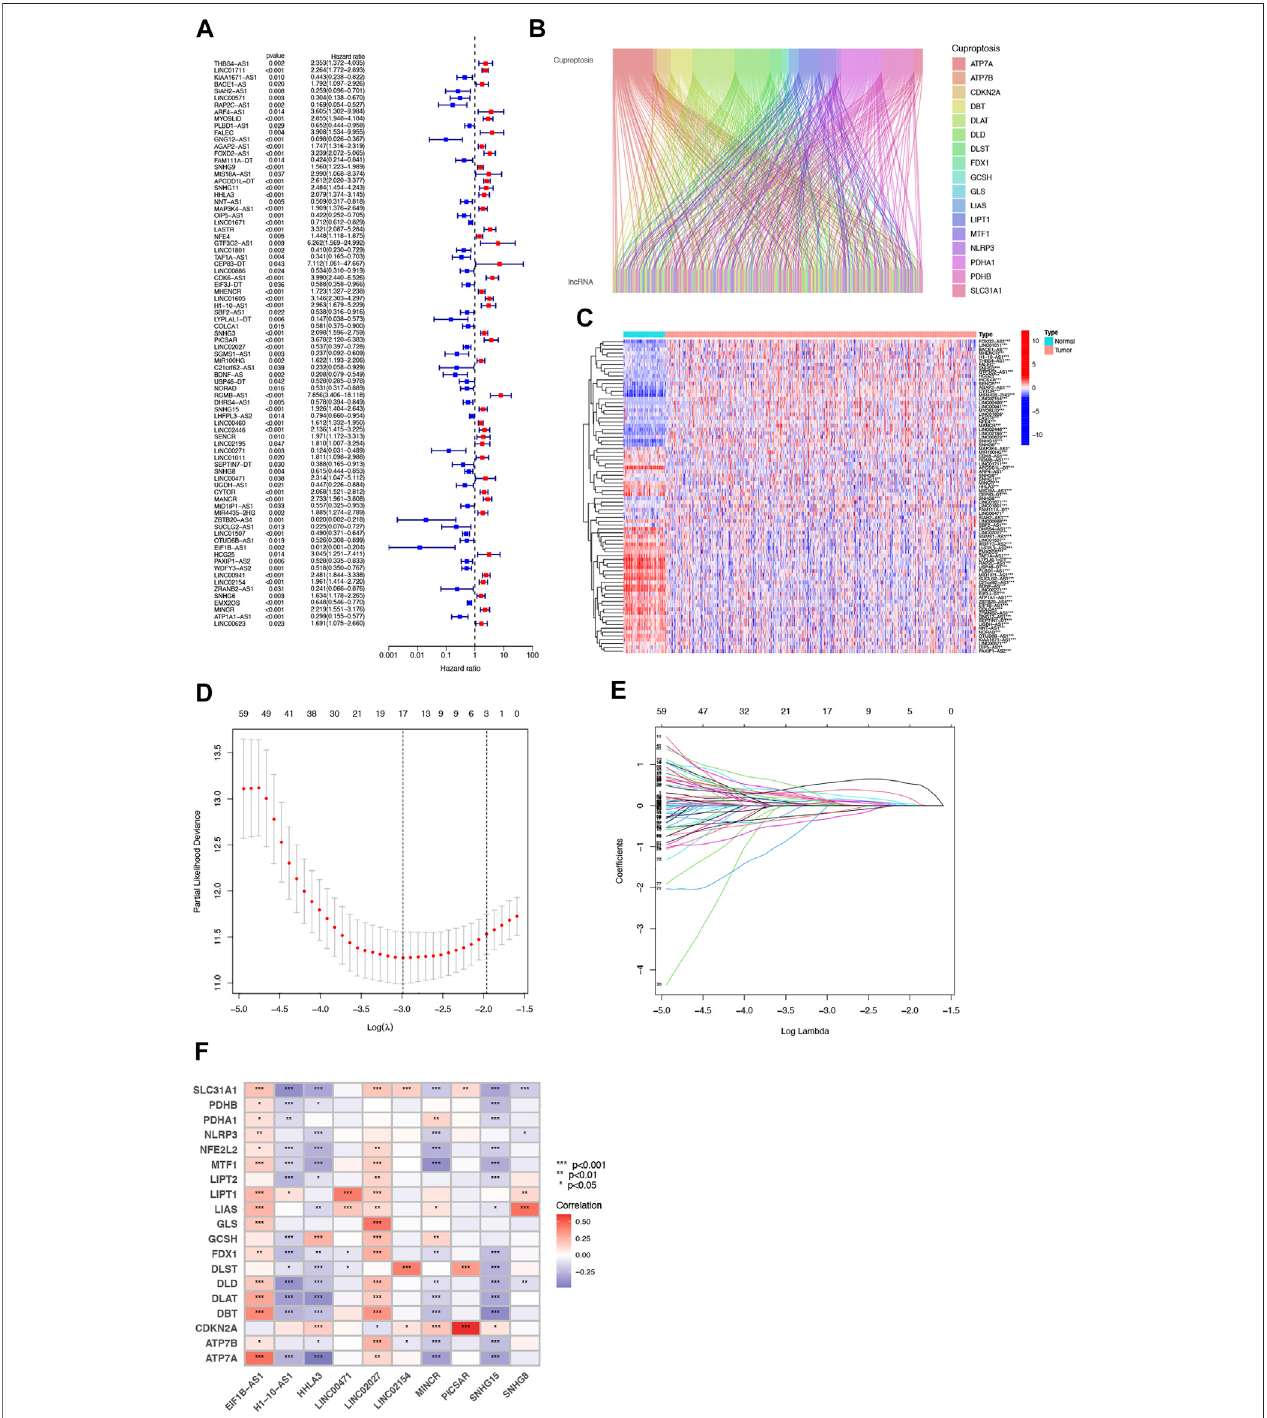
FIGURE 1 | Identi fi cation of Cuproptosis-associated lncRNA prognostic features in ccRCC. The forest plot shows prognosis-related genes for cuproptosis- associated lncRNAs (A) . Sankey relationship diagram of cuproptosis genes and cuproptosis-associated lncRNAs (B) . Differential expression of 81 cuproptosis- associated lncRNAs associated with survival between ccRCC and normal samples (C) . Distribution of the LASSO coef fi cients of cuproptosis-associated lncRNAs (D) . The 10-fold cross-validation of variable selection in the least absolute shrinkage and selection operator (LASSO) algorithm (E) . Correlation of lncRNAs with cuproptosis-related genes in risk models (F)